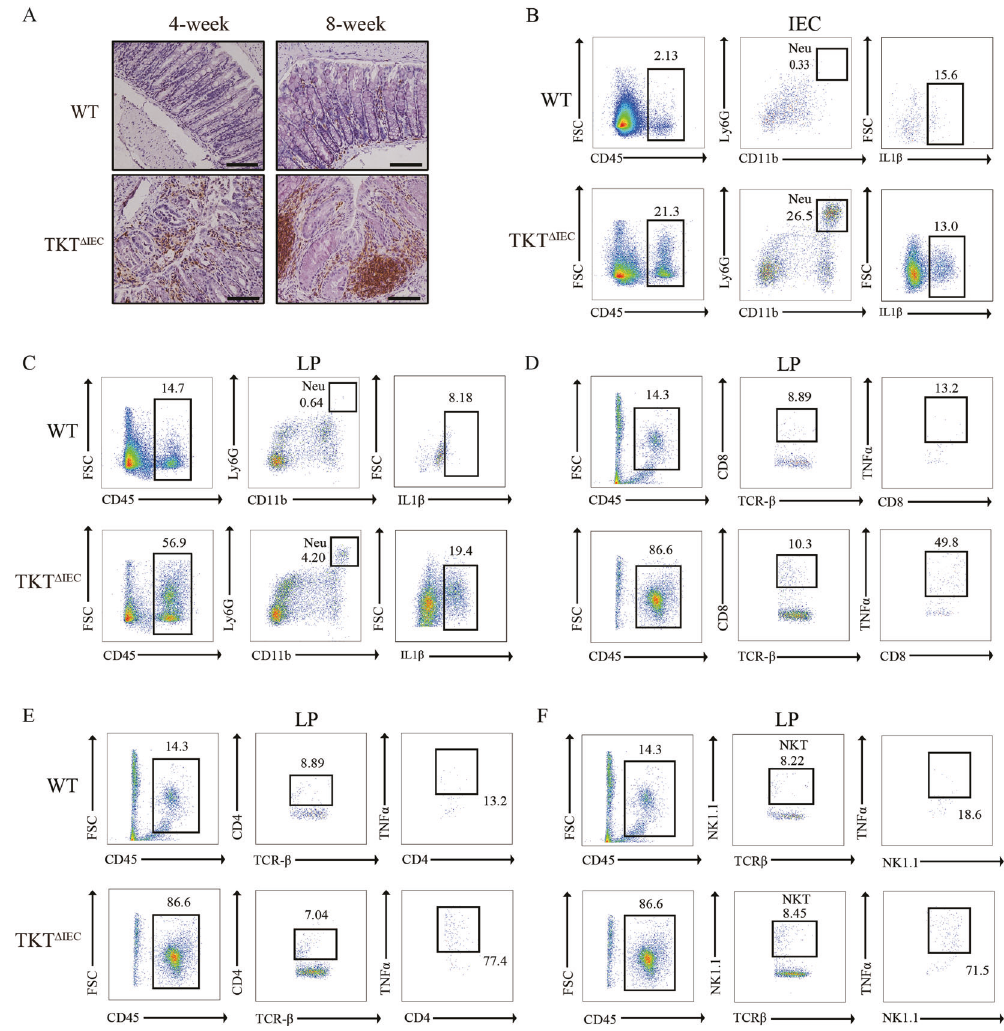
Fig. 3 TKT ablation in intestinal epithelium leads to massive in fi ltration of immune cells. A Representative images of colon sections stained with the CD45 antibody from WT and TKT Δ IEC mice at different ages. Scale bars, 100 μ m. B Representative fl ow cytometric analysis of IL-1 β from neutrophils in the IEC of colons from 6-week-old WT and TKT Δ IEC mice ( n = 3). C Representative fl ow cytometric analysis of IL-1 β from neutrophils in the LP of colons from 6-week-old WT and TKT Δ IEC mice ( n = 3). D Representative fl ow cytometric analysis of TNF α from CD8 + T cells in the LP of colons from 6-week-old WT and TKT Δ IEC mice ( n = 3). E Representative fl ow cytometric analysis of TNF α from CD4 + T cells in the LP of colons from 6-week-old WT and TKT Δ IEC mice ( n = 3). F Representative fl ow cytometric analysis of TNF α from NKT cells in the LP of colons from 6-week-old WT and TKT Δ IEC mice ( n =